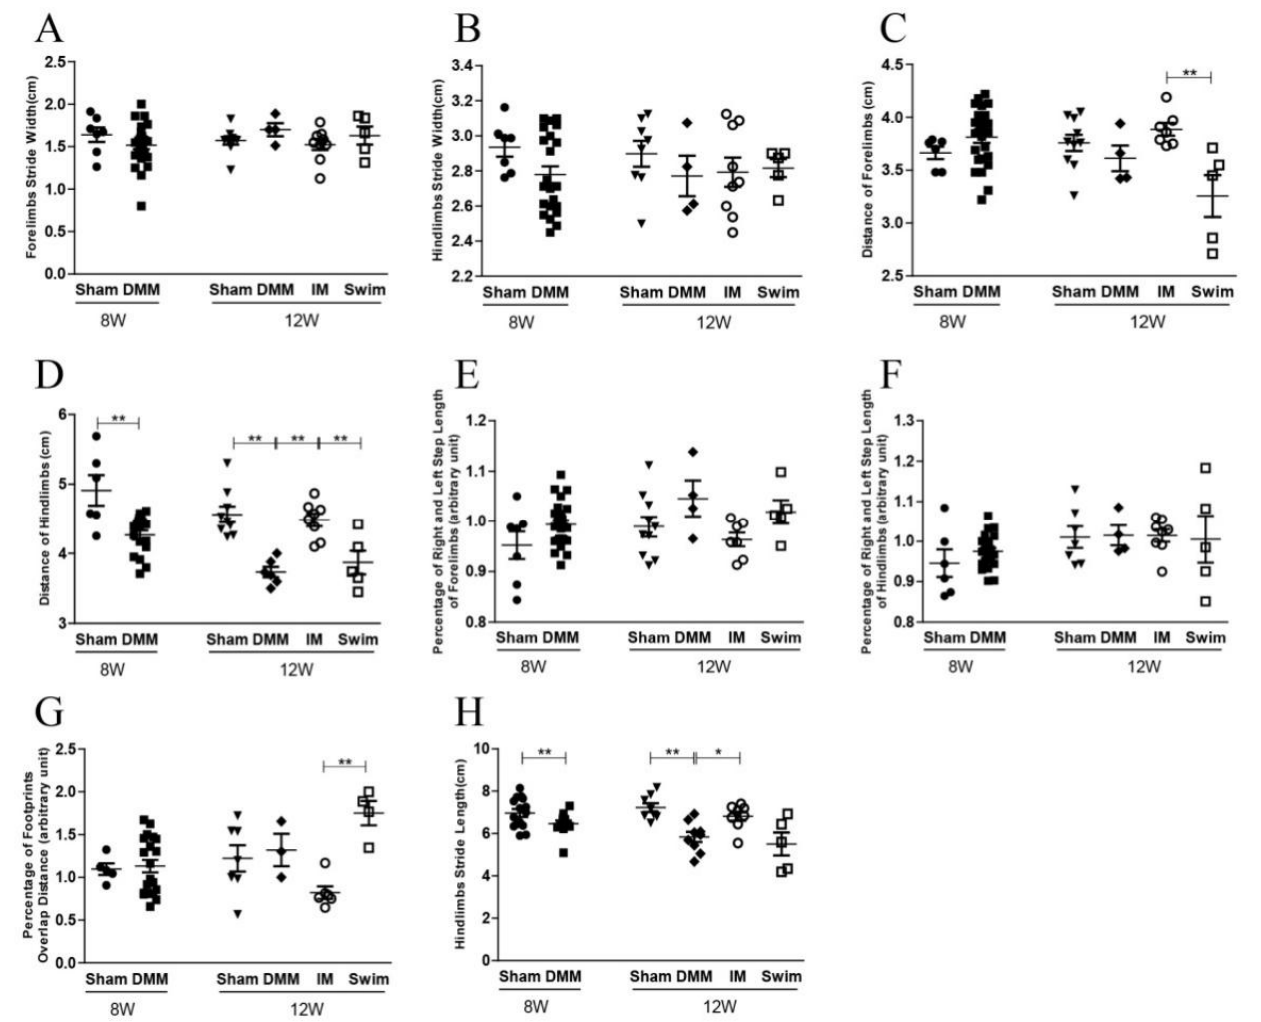
Figure 2. Ink blot analysis showing the effects of swimming and immobilization on the progression of OA at the late stage. ( A ) Forelimb stride width; ( B ) hindlimb stride width; ( C ) distance of forelimbs; ( D ) distance of hindlimbs; ( E ) percentage of right and left step length of forelimbs; ( F ) percentage of right and left step length of hindlimbs; ( G ) percentage of footprint overlap distance; ( H ) hindlimb stride length. 8W: the time point of starting swimming or immobilization, which is 8 weeks after DMM surgery. 12W: the time point after 4 weeks of swimming and immobilization, which is 12 weeks after DMM surgery. IM, immobilization; DMM, destabilization of the medial meniscus; * p < 0.05, ** p < 0.01, n ≥ 6.